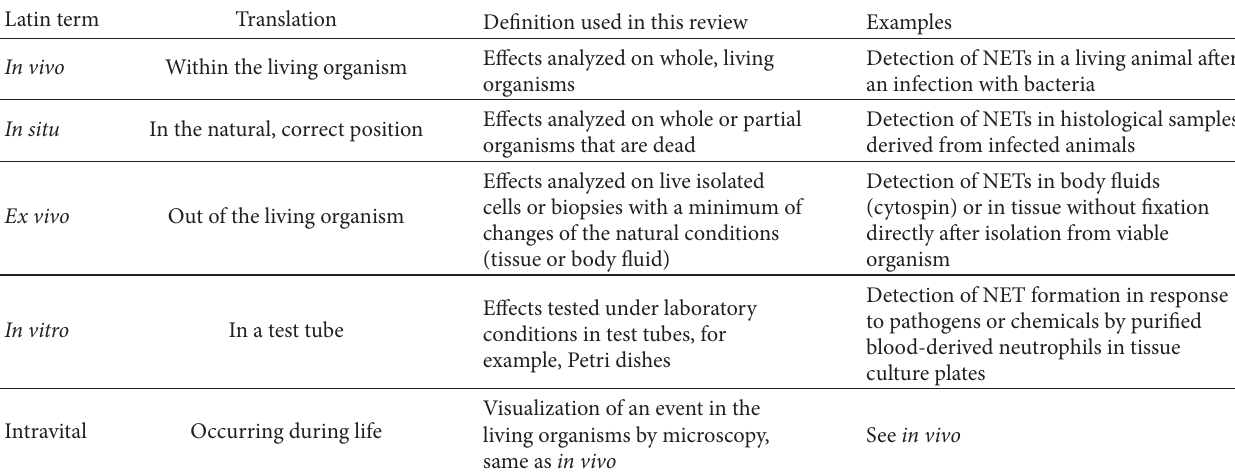
Table 2: Definition of Latin terms used in this paper for the detection of NETs in viable or fixed samples and